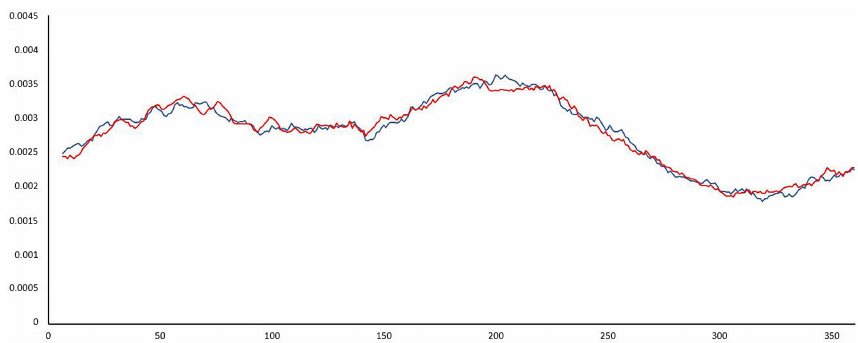
Figure 3. Frequency distributions of slopes (SLM02 in blue and SLM05 in red).